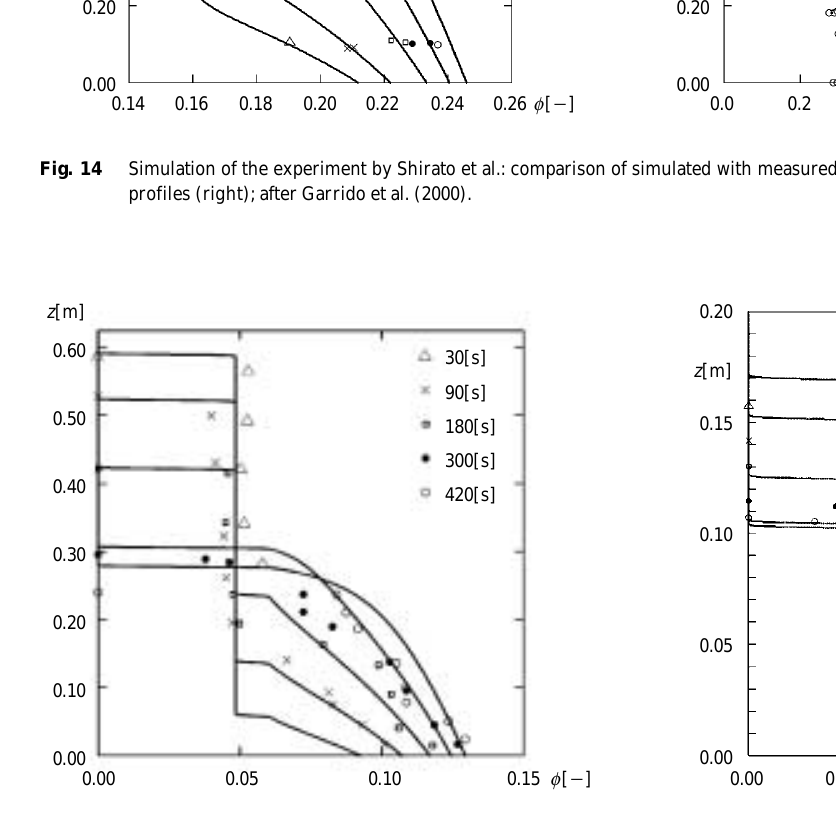
Comparison of concentration profiles measured by Shih et al. (1986) with numerical simulation of the settling experiment, after Garrido et al. (2000).